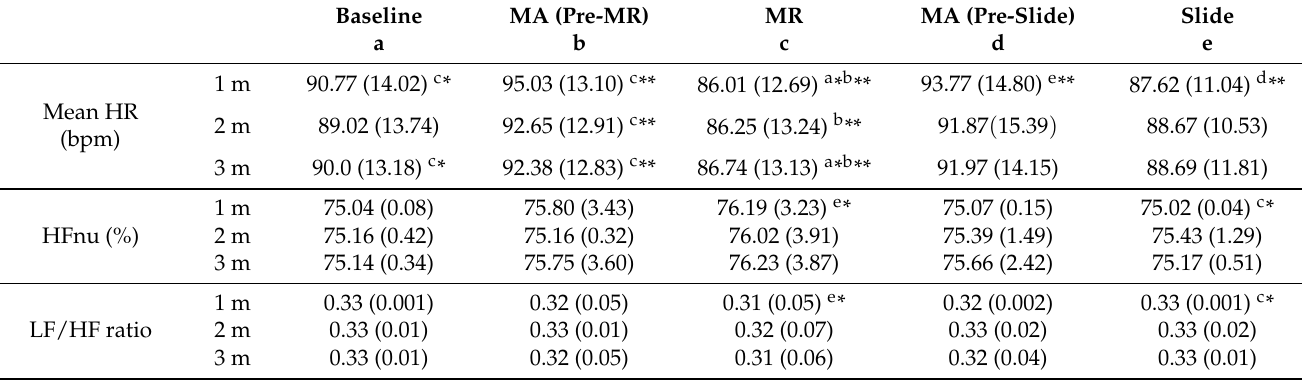
Table 2. ECG result for each parameter—mean (SD), superscripts indicate significant differences across columns; * p < 0.05; ** p < 0.01; a—baseline; b—MA (pre-MR); c—MR; d—MA (pre-slide);